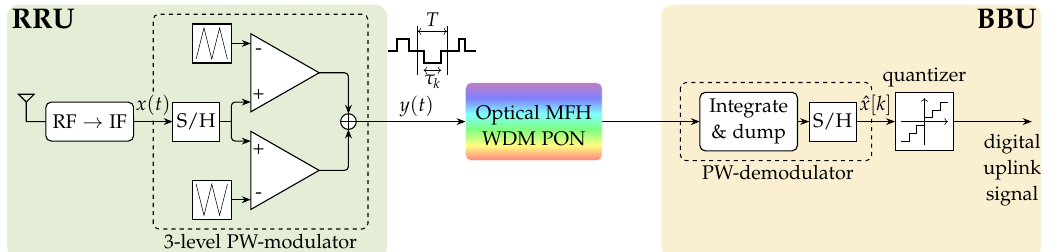
Figure 1. 3-level PWM mo-demodulation scheme with reference to the uplink.